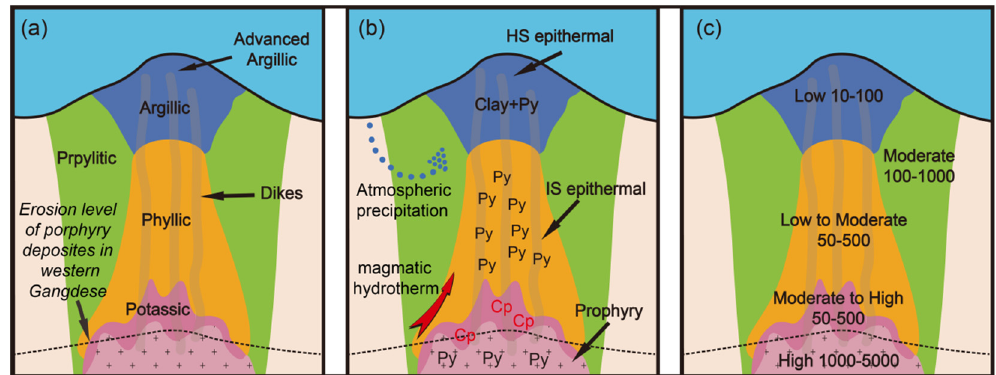
Figure 1. ( a ) Typical porphyry system alteration pattern; ( b ) Expected sulfide mineralization; ( c ) Expected electrical resistivity responses for uneroded and eroded porphyry deposits. Py = pyrite, Cp = chalcopyrite. Modified from [12] and [15].